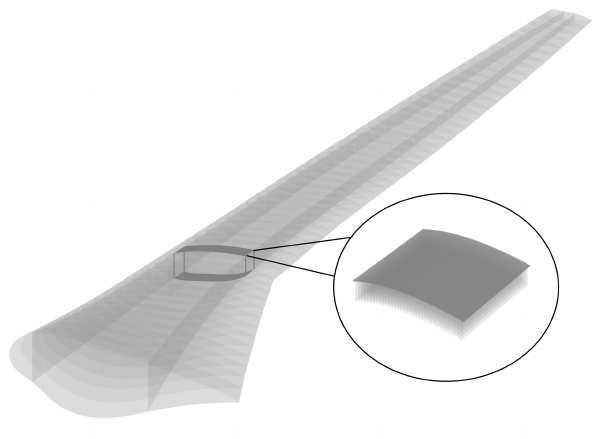
Figure 4. Global–local modeling approach.